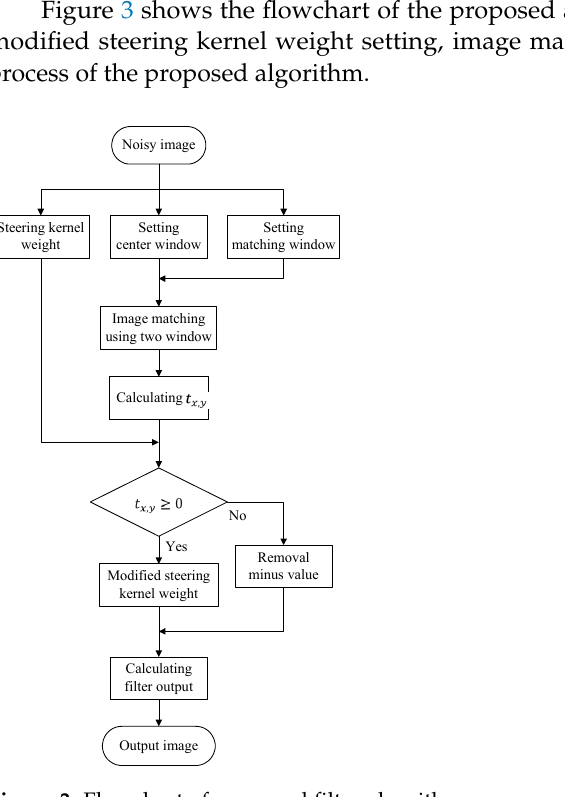
Figure 3. Flowchart of proposed filter algorithm.